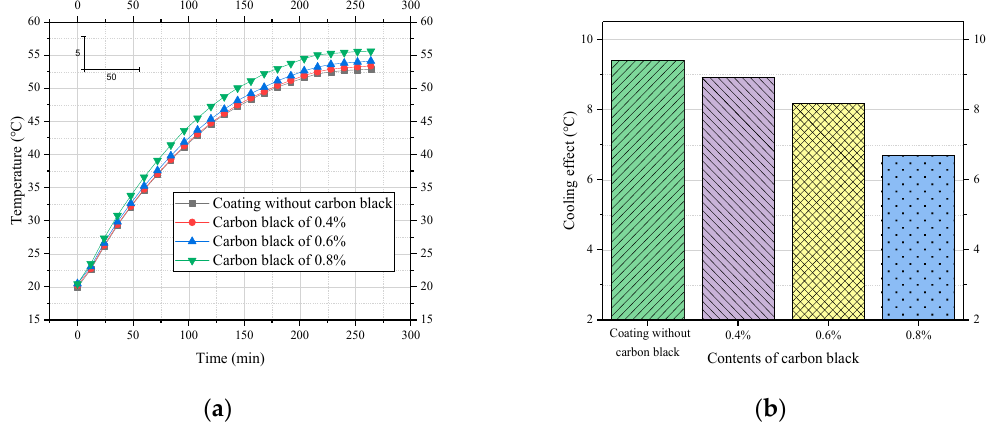
Figure 7. Effect of carbon black on the cooling performance of coatings. ( a ) Process of heating to thermal equilibrium; ( b ) comparison of cooling effects.